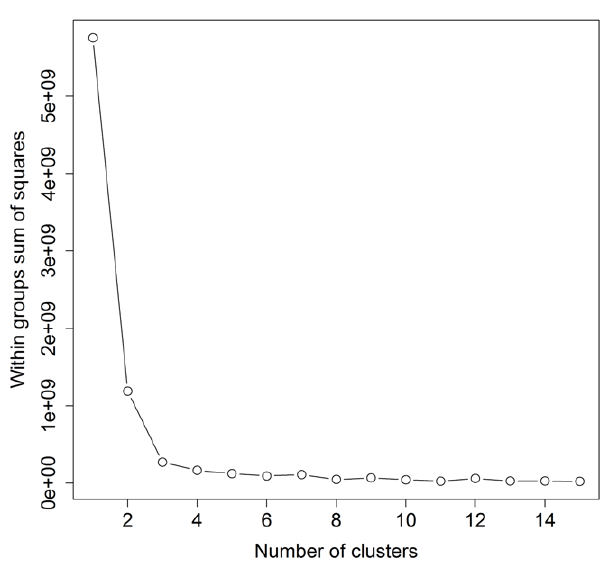
Figure 3. Graphical results of a K -means analysis indicating the appropriate number of clusters of water source-groupings, based on within-groups sum of squares as a function of the number of clusters from hierarchical cluster analysis of points of water use ( n =122), for the analysis of water availability to the Sable Island horses, 2008–2010. The first obvious bend indicates the appropriate number of groups (i.e., 3).